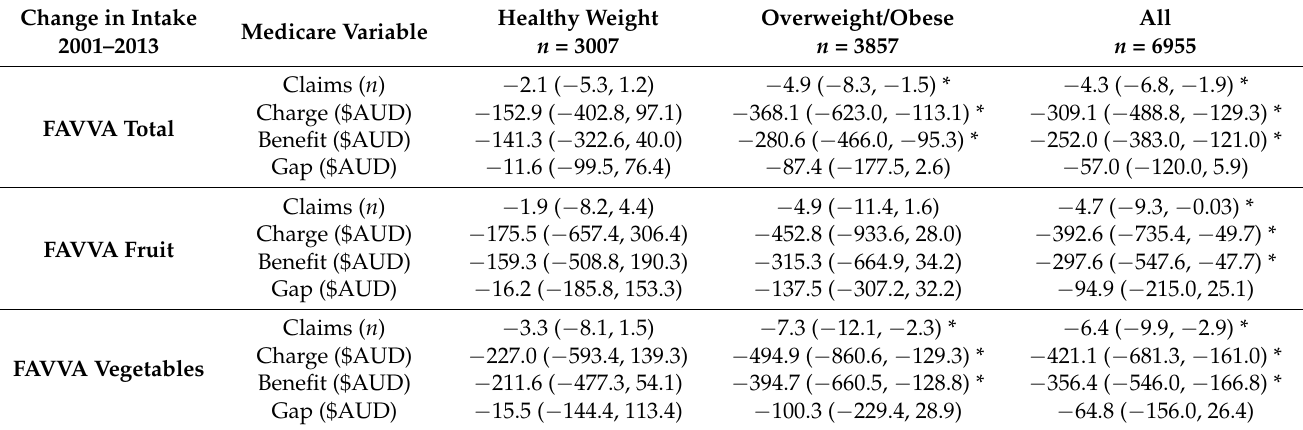
Table 4. Coefficients and 95% confidence intervals (CI) per 10-unit changes in the FAVVA (2001–2013) as a predictor of the 15-year (2001–2015) cumulative Medicare claims and costs for Australian women born in 1946–1951 ( n = 6955) and within the baseline BMI